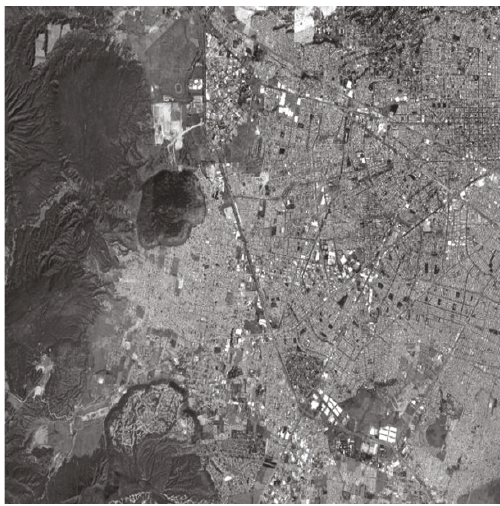
Figure 9: Original test scene borrowed from the high-resolution RS imagery.